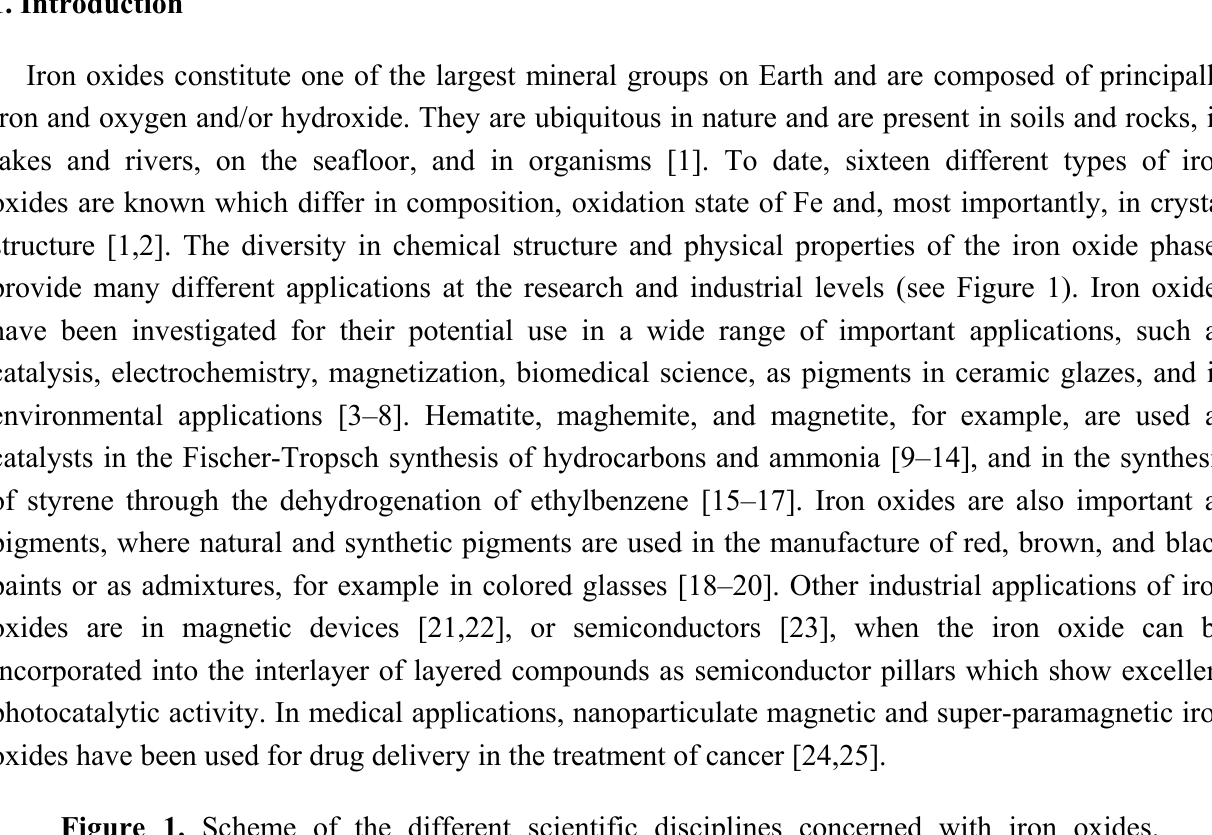
Figure 1. Scheme of the different scientific disciplines concerned with iron oxides. Reproduced with permission from reference [2]. Copyright 2003 John Wiley and